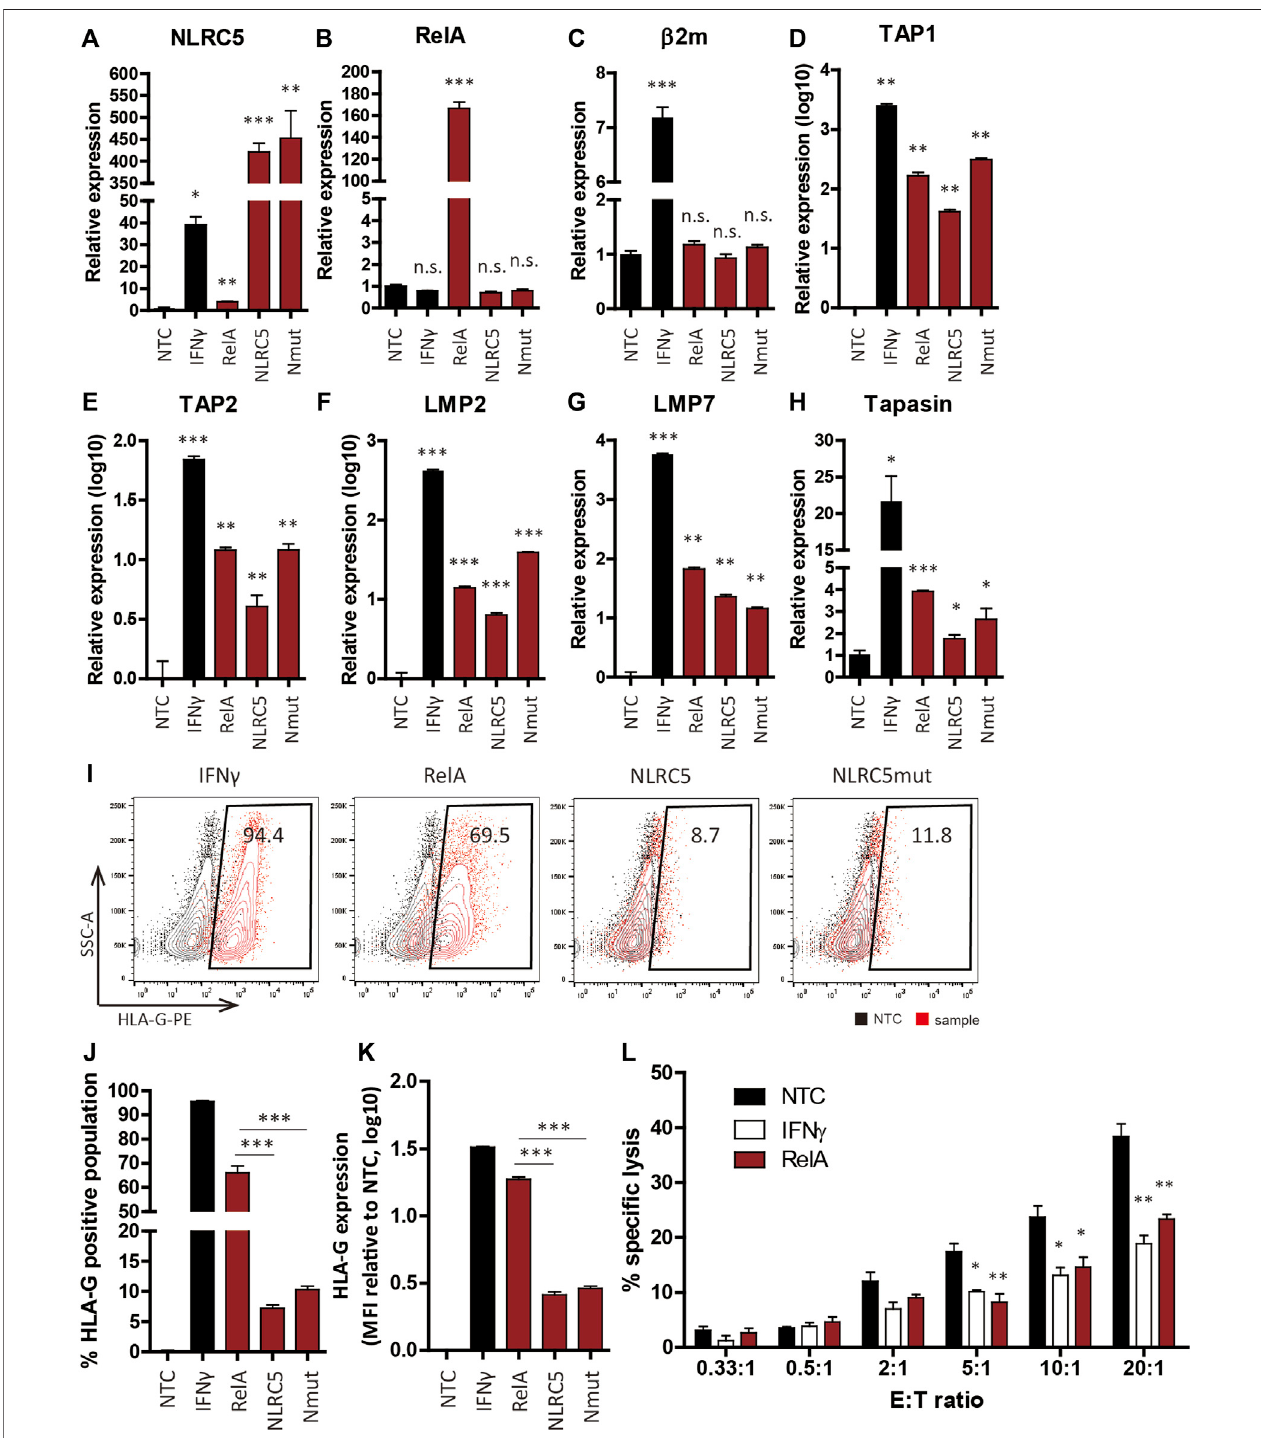
FIGURE 6 | Transcription factors recovered HLA-G expression in hypoimmunogenic cell lines. (A – H) mRNA levels in non-transfected control (NTC), IFN- γ -treated (IFN- γ ),RelA-transfected (RelA), NLRC5-transfected (NLRC5),and constitutivemutant formofNLRC5-transfected (Nmut)NSCs derived fromhypoimmunogeniciPSCs ( n = 4). (I) Representative fl ow cytometry plot of HLA-G surface presentation. (J,K) Percentage HLA-G-positive populations (J) and mean MFI values ( (K) , n = 4). (L) Percentages of NK cell-speci fi c lysis in NTCs (black), IFN- γ -treated (white), and RelA-transfected (red) cells were assessed at the indicated effector to target ratios (E:T ratios). Data means ± SEMs. * p < 0.05, ** p < 0.01, *** p < 0.001.